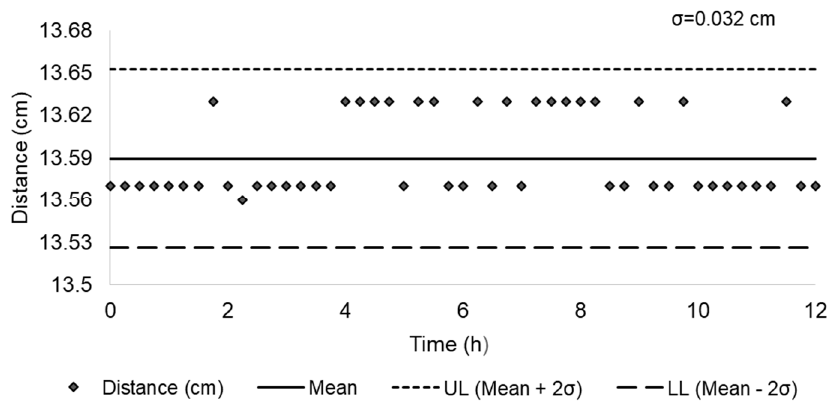
Figure 3. Ultrasonic ranging module calibration along 12 h.